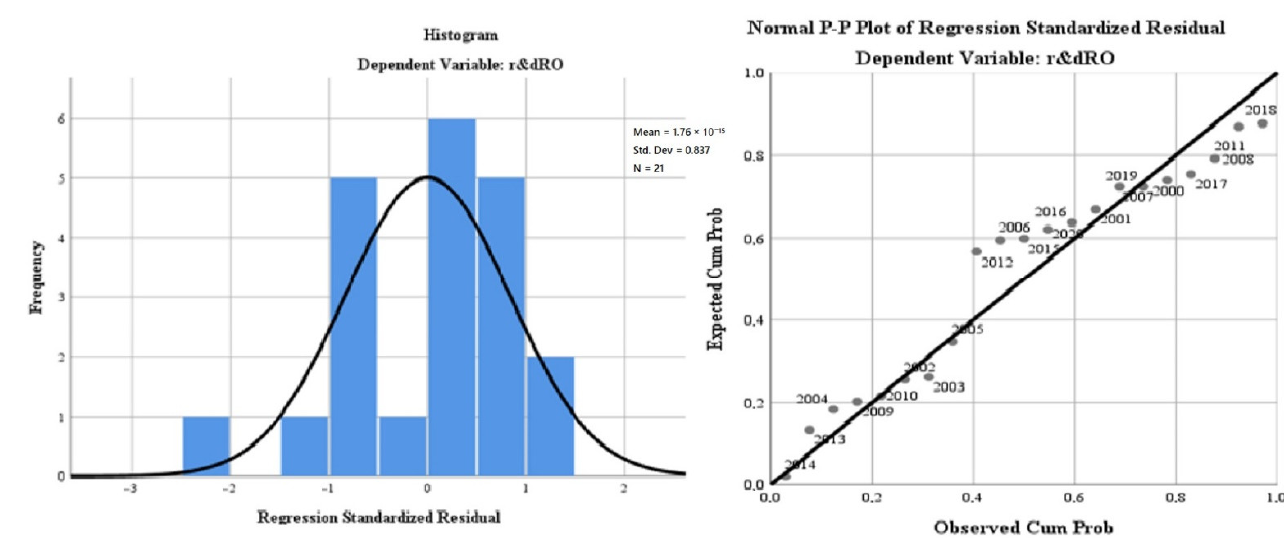
Figure 8. Regression analysis for Romania. Source: Data operated under IBM-SPSS 25 (IBM, Armonk, NY, USA).